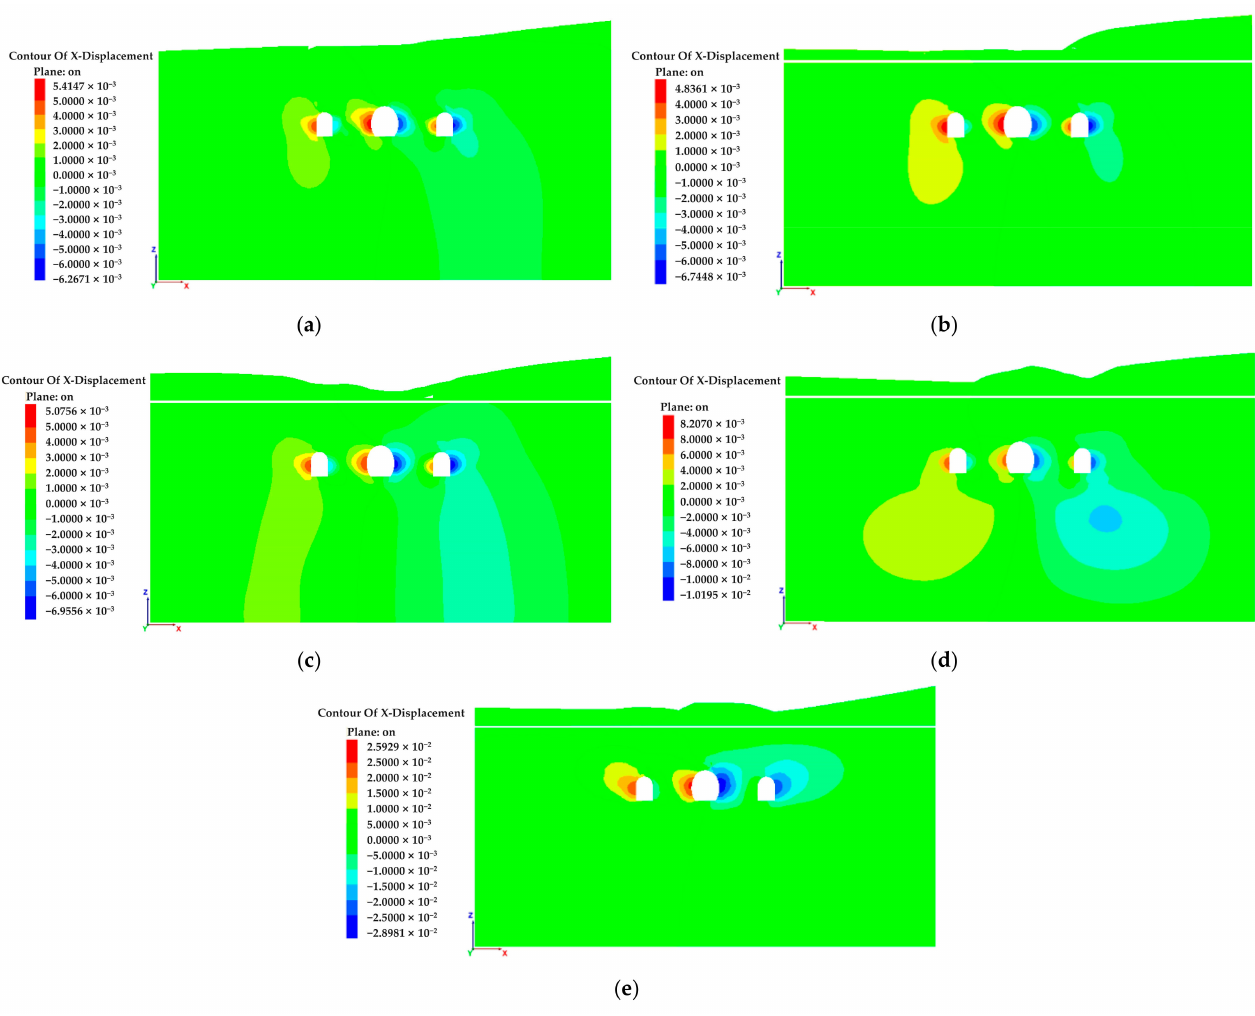
Figure 8. Horizontal deformation of surface and surrounding rock after pilot tunnel excavation (unit: m): ( a ) Y = 20 m; ( b ) Y = 40 m; ( c ) Y = 60 m; ( d ) Y = 80 m; and ( e ) Y = 100